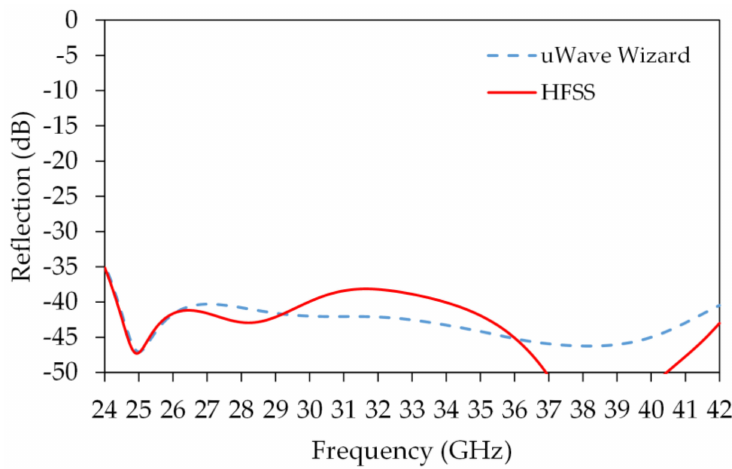
Figure 5. Simulated reflection of the designed E-plane bend. Results from µ Wave Wizard in dashed blue line and from HFSS in solid red line.